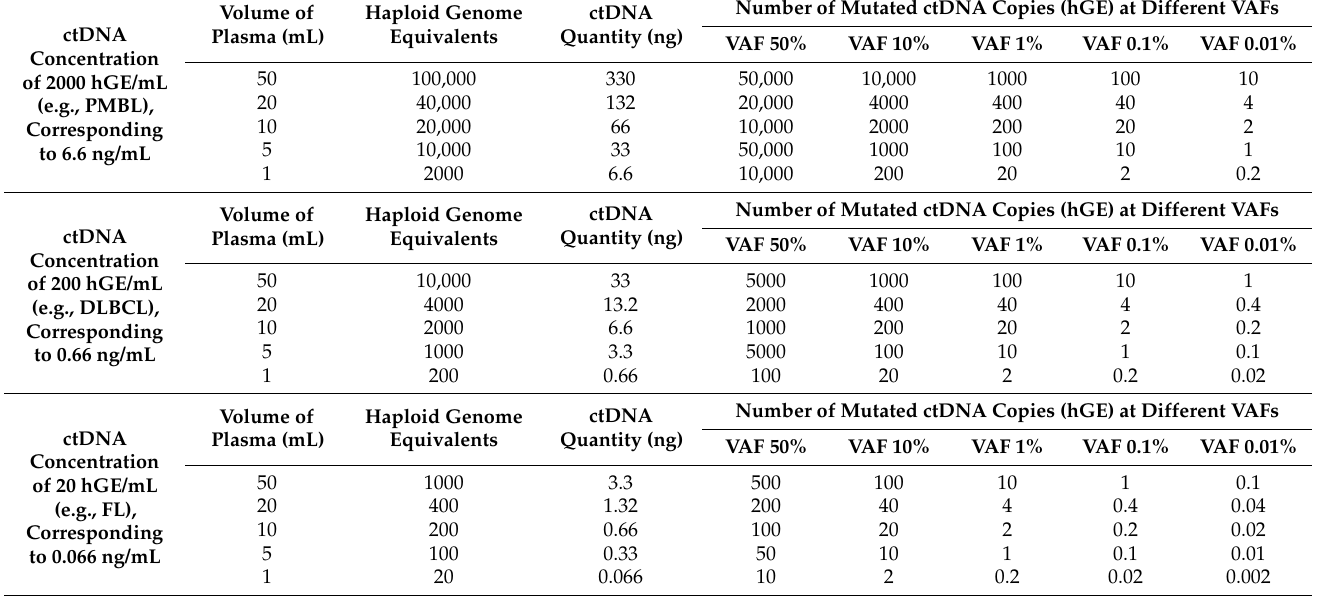
Table 1. Number of mutated ctDNA molecules that might be expected according to the volume of plasma collected, and the tumor and variant allele fraction (VAF) of the mutation. Three situations are envisaged: top: ctDNA = 2000 hGE/mL (e.g., 4000 hGE/mL of total cfDNA with 50% being tumor-derived); middle: ctDNA = 200 hGE/mL (e.g., 400 hGE/mL of total cfDNA with 50% being tumor-derived); bottom: ctDNA = 20 hGE/mL (e.g., 40 hGE/mL of total cfDNA with 50% being tumor-derived). Color key according to the number of ctDNA copies harboring the variant (red 0–10; orange 11–100; green >